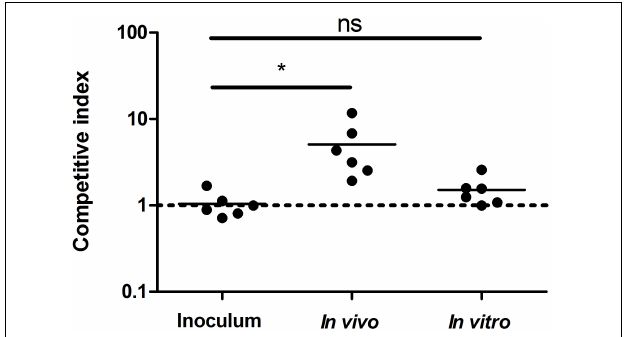
FIGURE 5 | Infection and intracellular viability assay of Brucella abortus in J774 mouse macrophages in vitro . J774 macrophages were infected with either B. abortus 292 or the CO 2 -independent spontaneous mutant B. abortus 292mut1, at a multiplicity of infection (MOI) of 50. Samples from triplicate wells were obtained at 0, 4, 10, 24, and 48 h post infection and enumerated by dilution and plating.